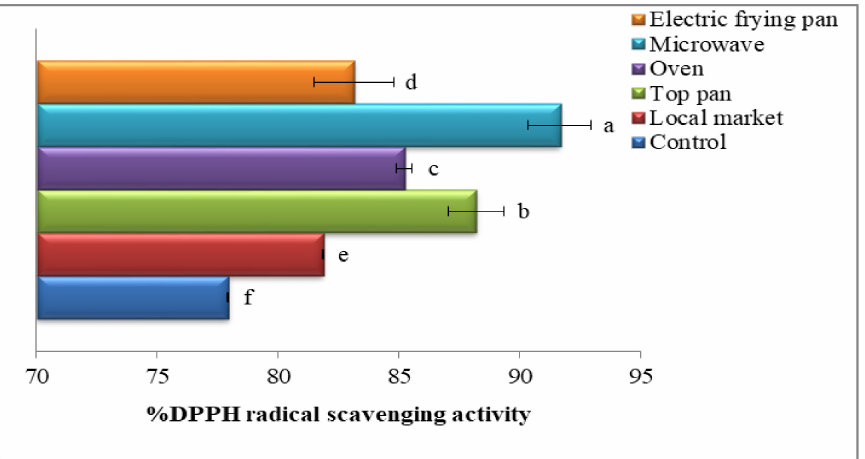
Figure 6. Antioxidant activity (%) of oils recovered from sesame roasted with different methods. Significant variations at p ≤ 0.05 are indicated by vertical bars with SD (n = 3) and different letters on the bars of every sample.